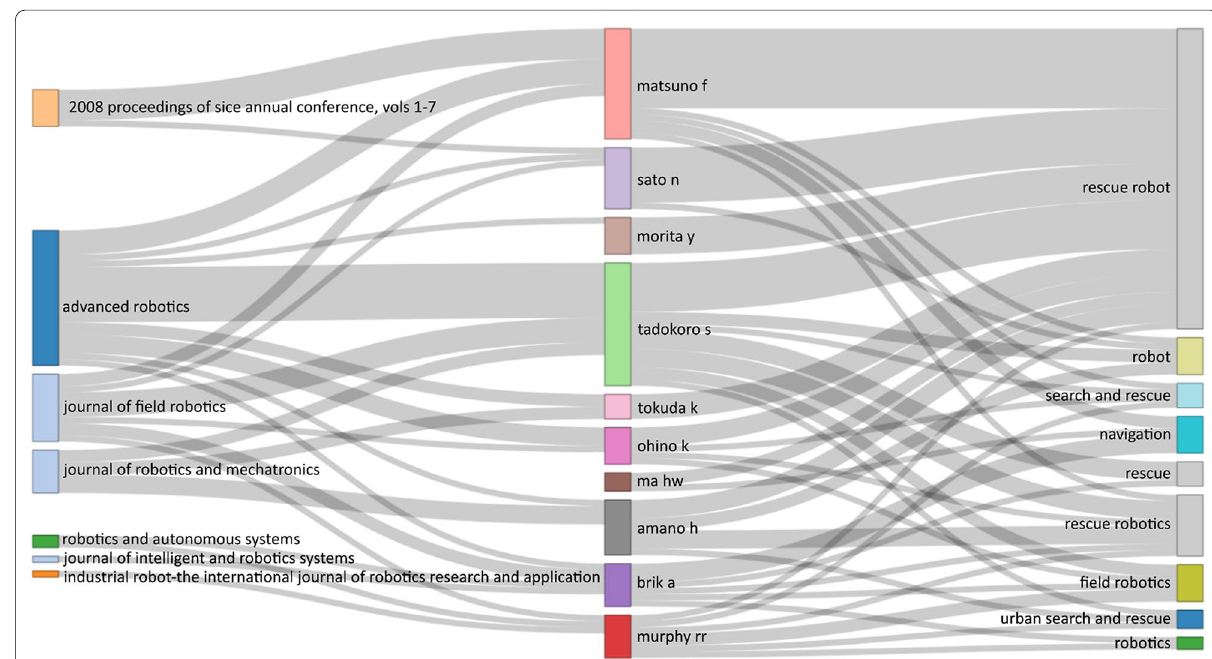
Fig. 10 Scientific correlation between prominent authors (middle), bibliometric sources (left), and frequent keywords (right) in RR